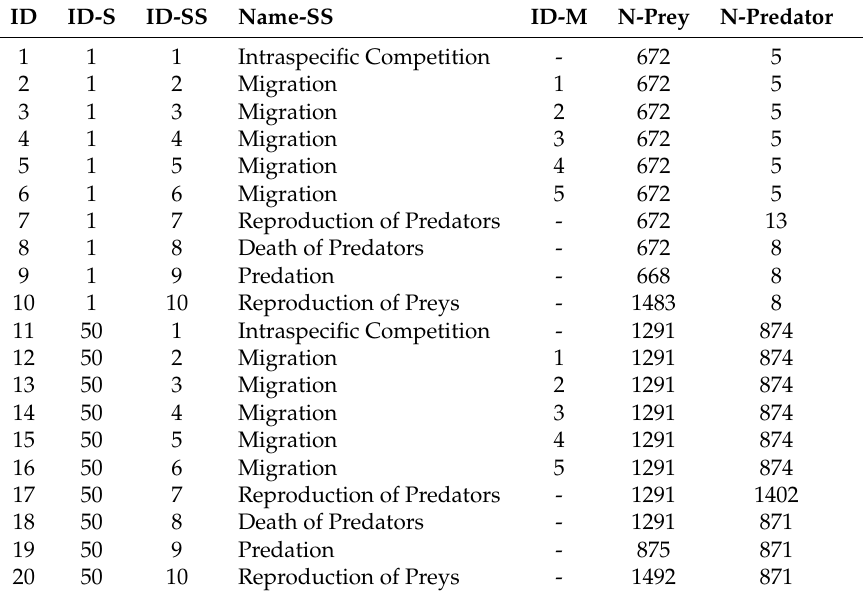
Table 9. Simulation performed using agents—Case